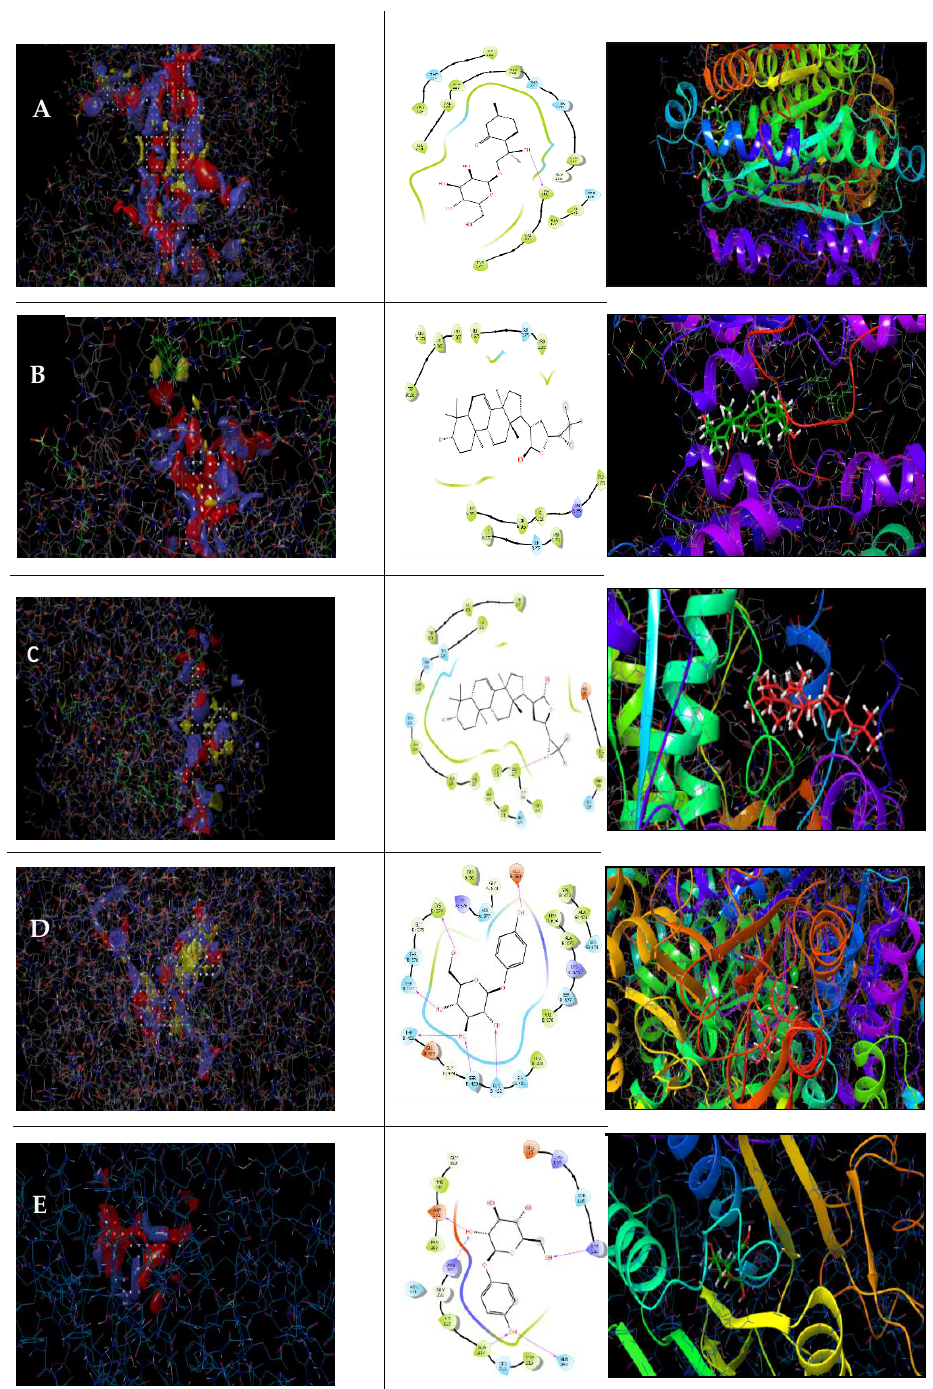
Figure 7. Based on site maps ( left ), interactions of five receptor proteins with seven ligands ( right ). Highest docking scorers are shown: ( A ) schizonepetoside showed the highest docking score (–8.145) with IXU9; ( B ) melianol (highest docking score, –8.475) with receptor IXU7; ( C ) melianol (highest docking score –8.995) with receptor 2BEL; ( D ) arbutin (highest docking score, –7.492) with receptor GR4F, and ( E ) 3- O -benzoyl-20-deoxyingenol (highest docking score, –6.123) with receptor 3A5J. In each case, gliclazide and metformin were used as reference antidiabetic drugs (Supplementary Materials).